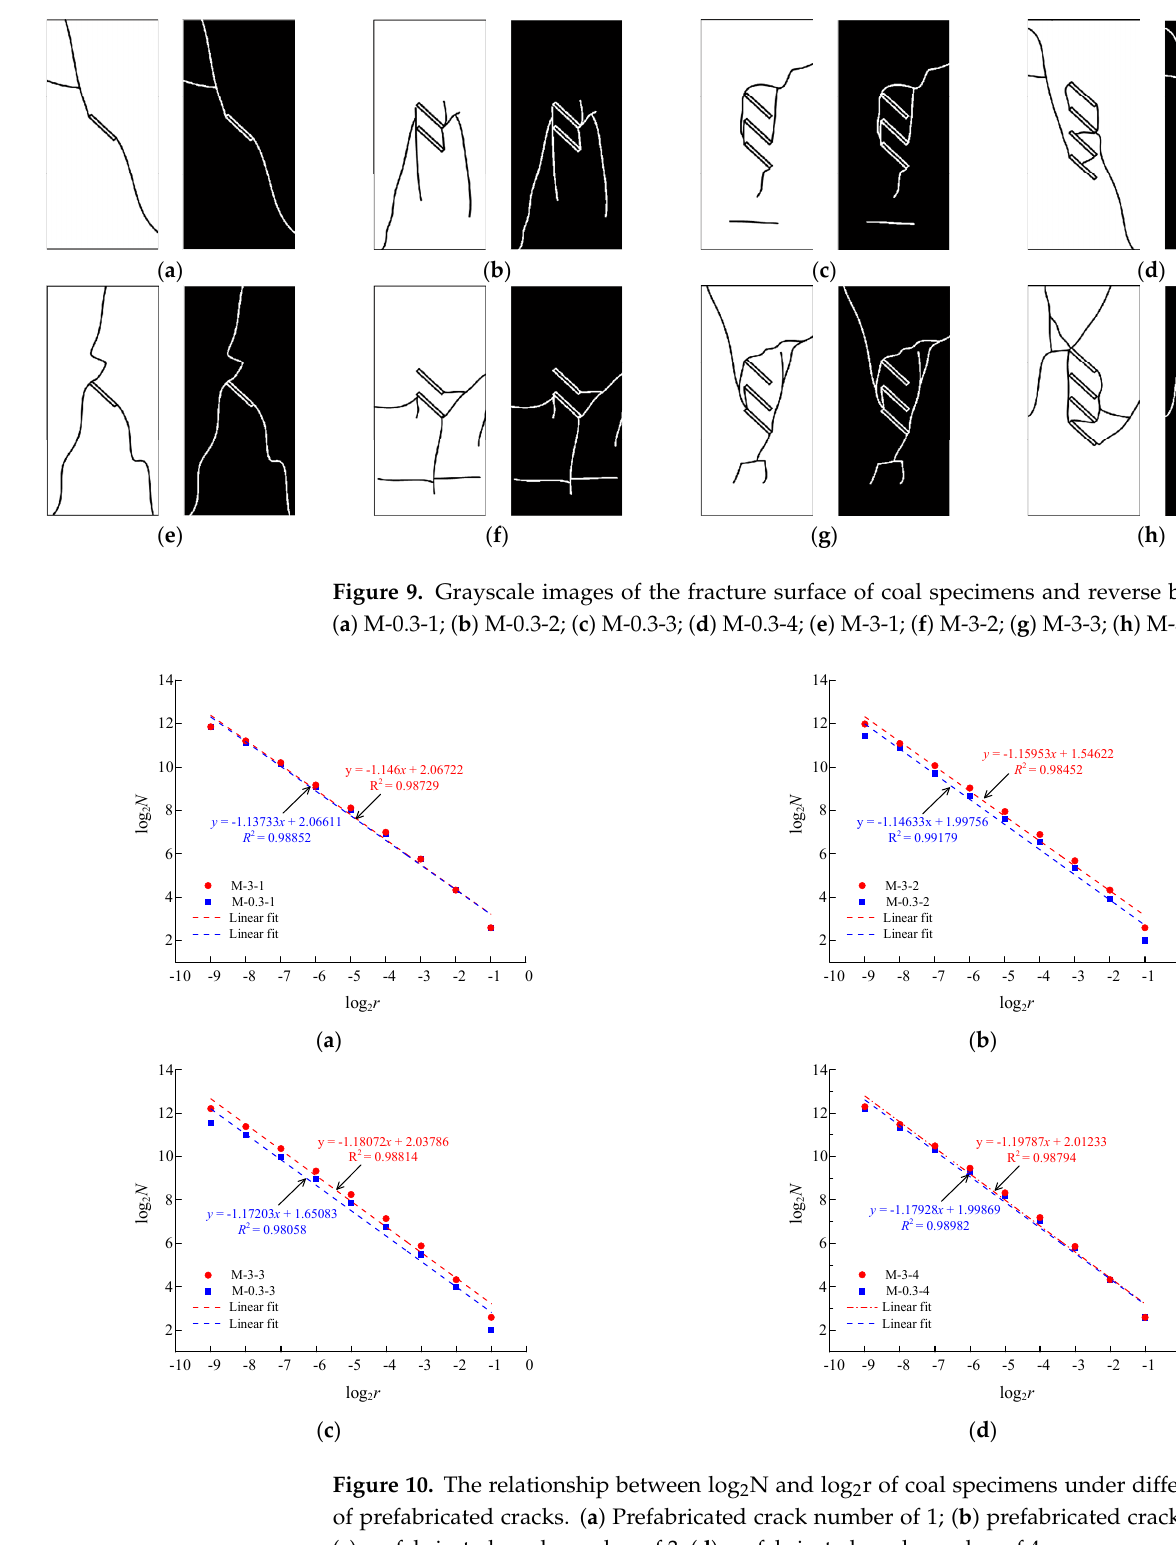
Figure 10. The relationship between log 2 N and log 2 r of coal specimens under different numbers of prefabricated cracks. ( a ) Prefabricated crack number of 1; ( b ) prefabricated crack number of 2; ( c ) prefabricated crack number of 3; ( d ) prefabricated crack number of 4.